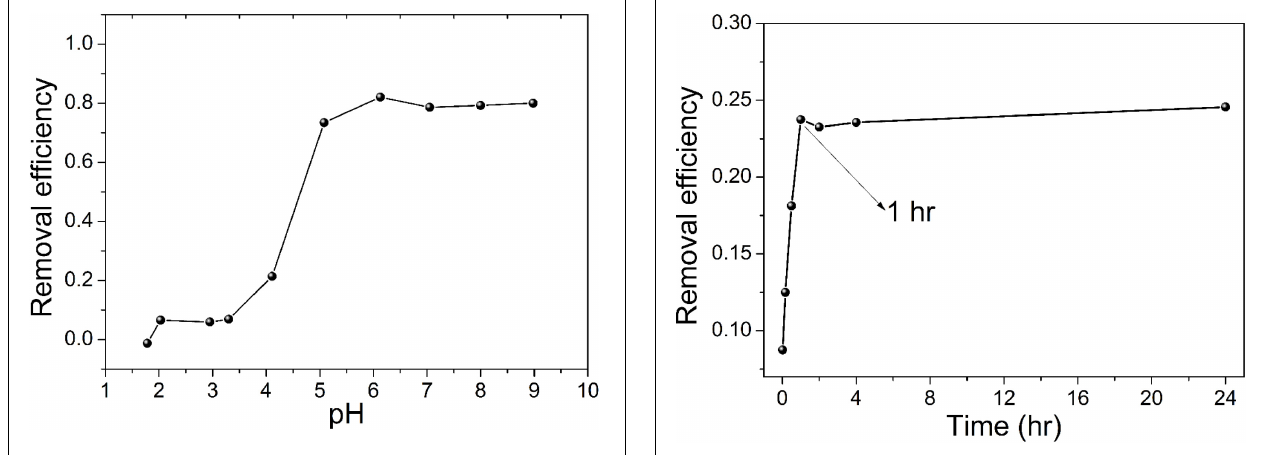
FIGURE 4 | Effect of pH on the removal of uranium (VI) ( C 0 = 8 mg L − 1 , t = 1 h, T = 298 K).